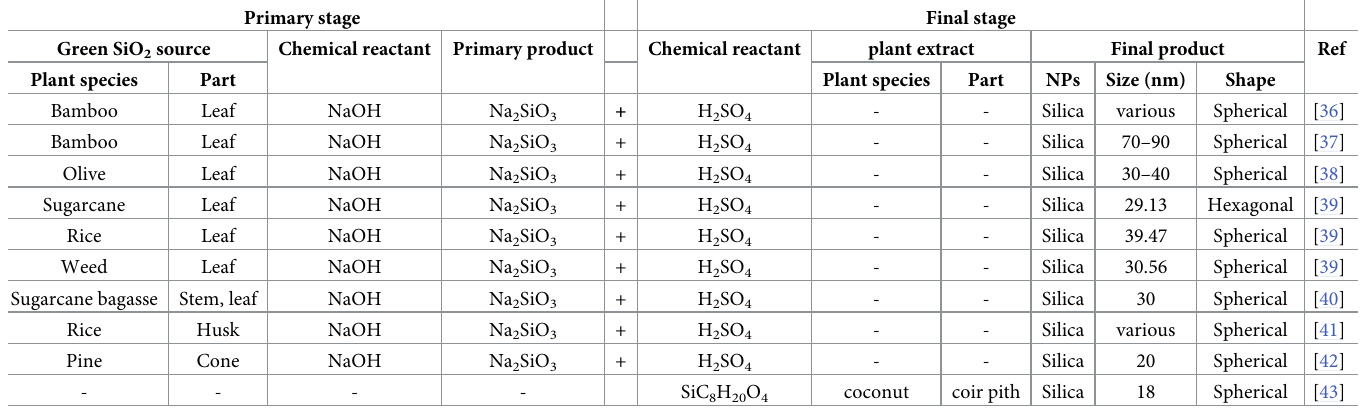
Table 1. Production nanosilica using green synthesis in